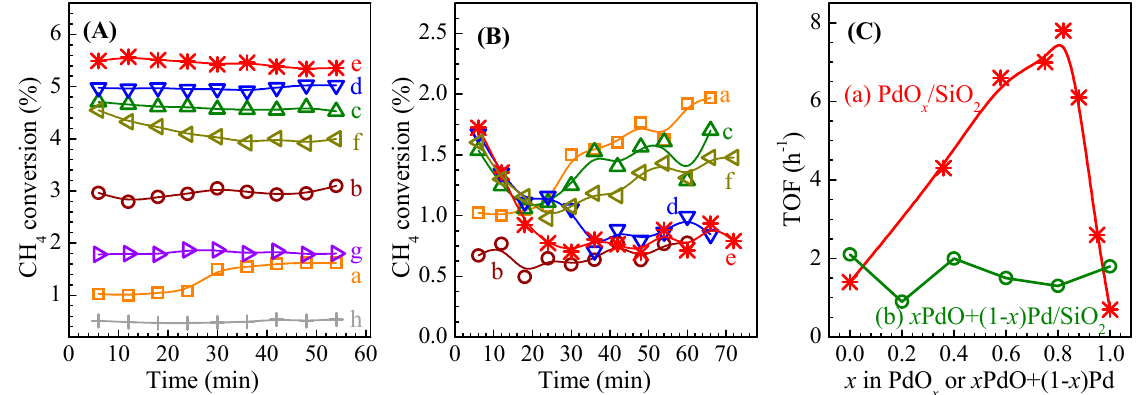
Figure 4. Lean methane oxidation at 230 °C over the Pd/SiO 2 -Acac catalysts with different Pd oxidation states. ( A ) Methane conversion versus reaction time over the PdO x /SiO 2 -Acac series catalysts: ( a ) Pd/SiO 2 -Acac; ( b ) PdO 0.36 /SiO 2 -Acac; ( c ) PdO 0.58 /SiO 2 -Acac; ( d ) PdO 0.75 /SiO 2 -Acac; ( e ) PdO 0.82 /SiO 2 -Acac; ( f ) PdO 0.88 /SiO 2 -Acac; ( g ) PdO 0.95 /SiO 2 -Acac; ( h ) PdO/SiO 2 -Acac. ( B ) Methane conversion versus reaction time over the x PdO + (1 − x )Pd/SiO 2 -Acac series catalysts: ( a ) Pd/SiO 2 -Acac; ( b ) 0.2 PdO + 0.8 Pd/SiO 2 -Acac; ( c ) 0.4 PdO + 0.6 Pd/SiO 2 -Acac; ( d ) 0.6 PdO + 0.4 Pd/SiO 2 -Acac; ( e ) 0.8 PdO + 0.2 Pd/SiO 2 -Acac; ( f ) PdO/SiO 2 -Acac. ( C ) Turnover frequency (TOF, as specified later in the experimental section) versus the value of x in the PdO x /SiO 2 -Acac series ( a ) or the x PdO + (1 − x )Pd/SiO 2 -Acac series ( b ) catalysts. The reactions were conducted at 230 °C, with the feed of 1 vol.% CH 4 and 99 vol.% air and a GHSV of 30,000 mL h − 1 g − 1 .